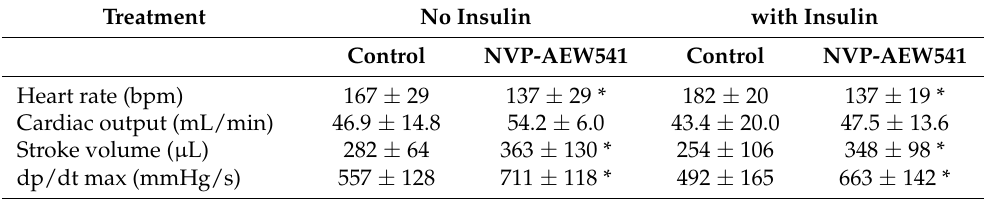
Table 1. Effects NVP-AEW541 on cardiac function during ex vivo isolated heart perfusion.